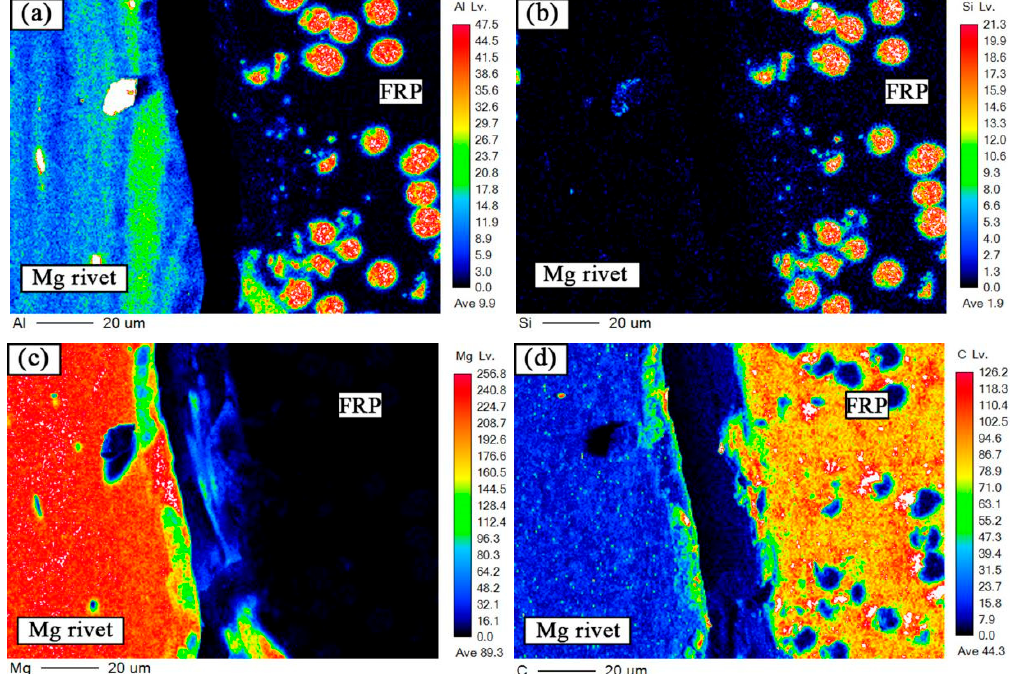
Figure 10. EPMA of the B region in Figure 5d. Elements distribution of ( a ) Al, ( b ) Si, ( c ) Mg, and ( d )